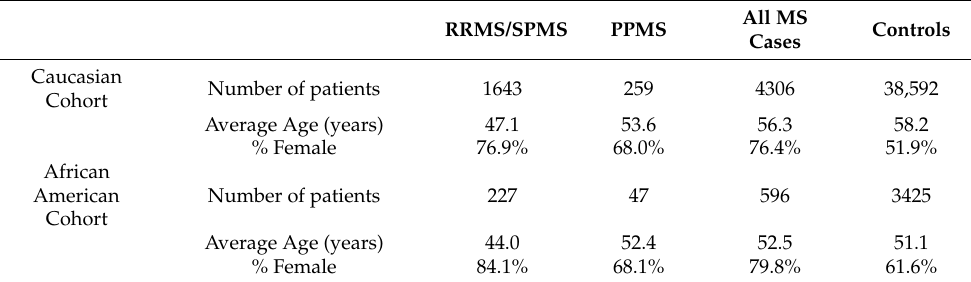
Table 1. Demographic and clinical data of the study